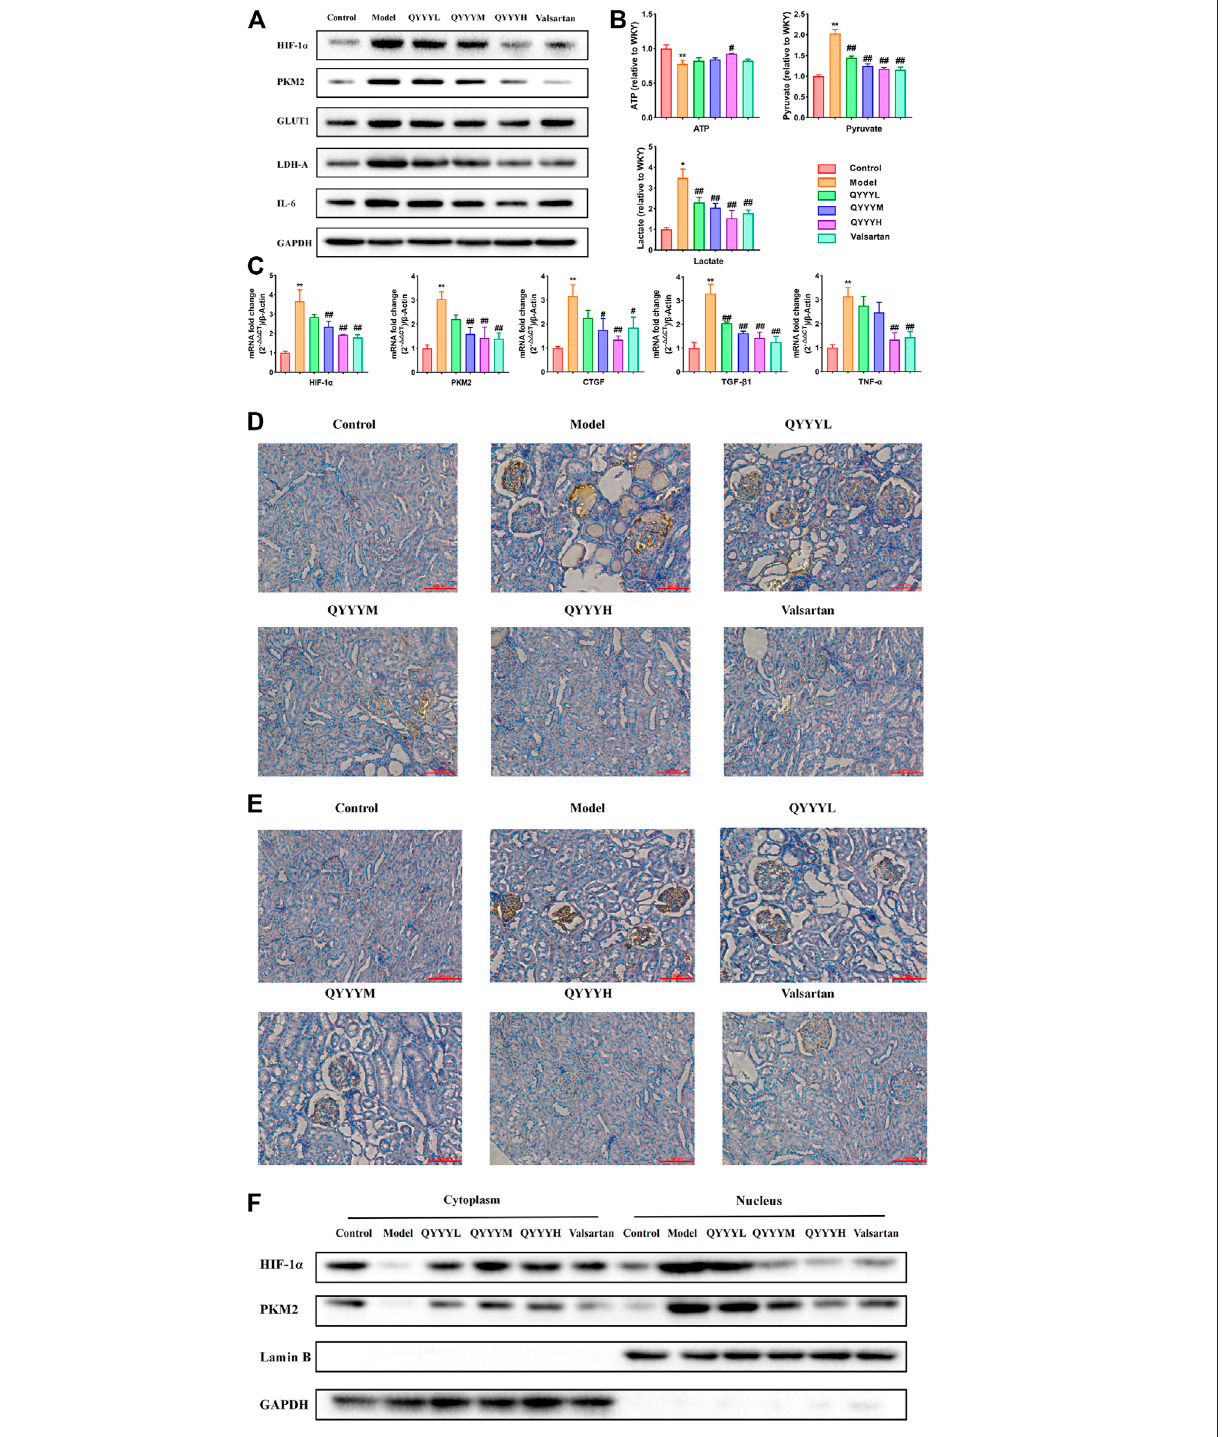
FIGURE3| QYYYpromotedHIF-1 α ,PKM2,metabolicmarkers,renalin fl ammationand fi brosis invivo . (A) EffectsofQYYYonproteinexpressionofHIF-1 α ,PKM2, GLUT1, LDH-A, and IL-6 in SHR were examined using western blotting. (B) Effects of QYYY on changes of ATP, pyruvate and lactate using kits. (C) Effects of QYYY on mRNA levels of HIF-1 α , PKM2, CTGF, TGF- β 1 and TNF- α in SHR were examined using qPCR. (D) Effects of QYYY on protein level of HIF-1 α in SHR were examined by immunohistochemistry. (E) Effects of QYYY on protein level of PKM2 in SHR were examined by immunohistochemistry. (F) Effects of QYYY on nuclear and cytoplasmic protein expression ofHIF-1 α ,PKM2 inSHRwereexaminedusing westernblotting. * p < 0.05and ** p < 0.01ascompared withthecontrolgroup. # p < 0.05 and ## p < 0.01 as compared with the model group.